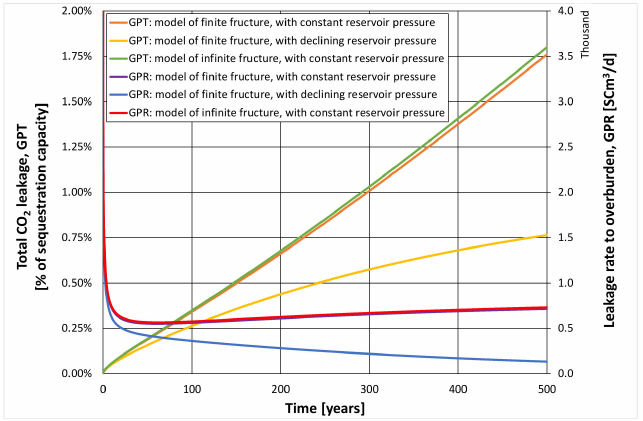
Figure 24. Rate and total CO 2 leakage to overburden. Scenarios for different fracture models and pressure conditions. Fracture range: lower anhydrite + old rock salt.